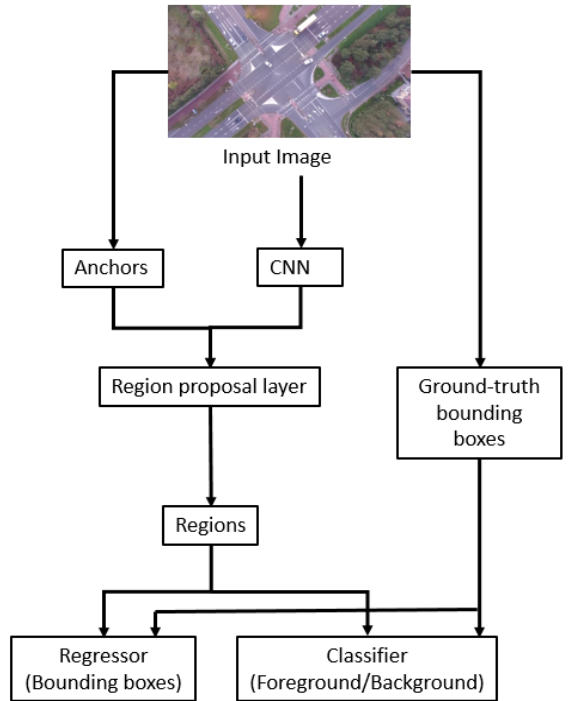
Figure 1. Region Proposal Network (RPN)